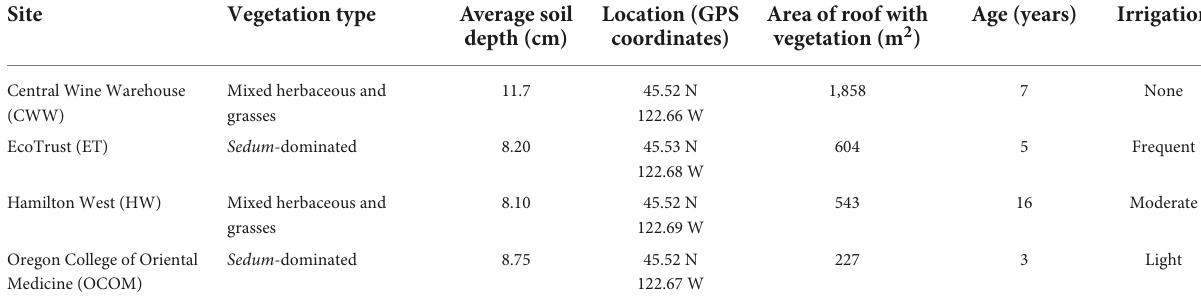
TABLE 1 Characteristics of four green roofs across Portland, Oregon in